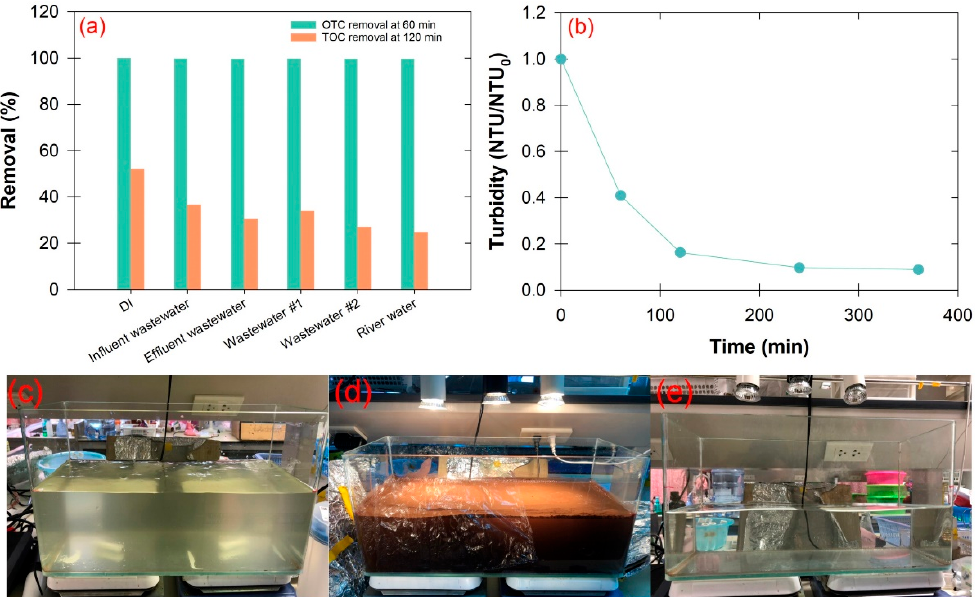
Figure 7. ( a ) Effect of real water matrices on OTC and TOC removal efficiency using the Cu 0.5 Mn 0.5 Fe 2 O 4 /H 2 O 2 /light system (Conditions: [OTC] 0 = 0.1 mM, catalyst loading = 0.2 g/L, [H 2 O 2 ] = 49.20 mM). ( b ) temporal changes in turbidity of real domestic wastewater using the Cu 0.5 Mn 0.5 Fe 2 O 4 /H 2 O 2 /light system, photo images of ( c ) before, ( d ) during, and ( e ) after the treatment (Conditions: catalyst loading = 0.2 g/L, [H 2 O 2 ] = 49.20 mM).